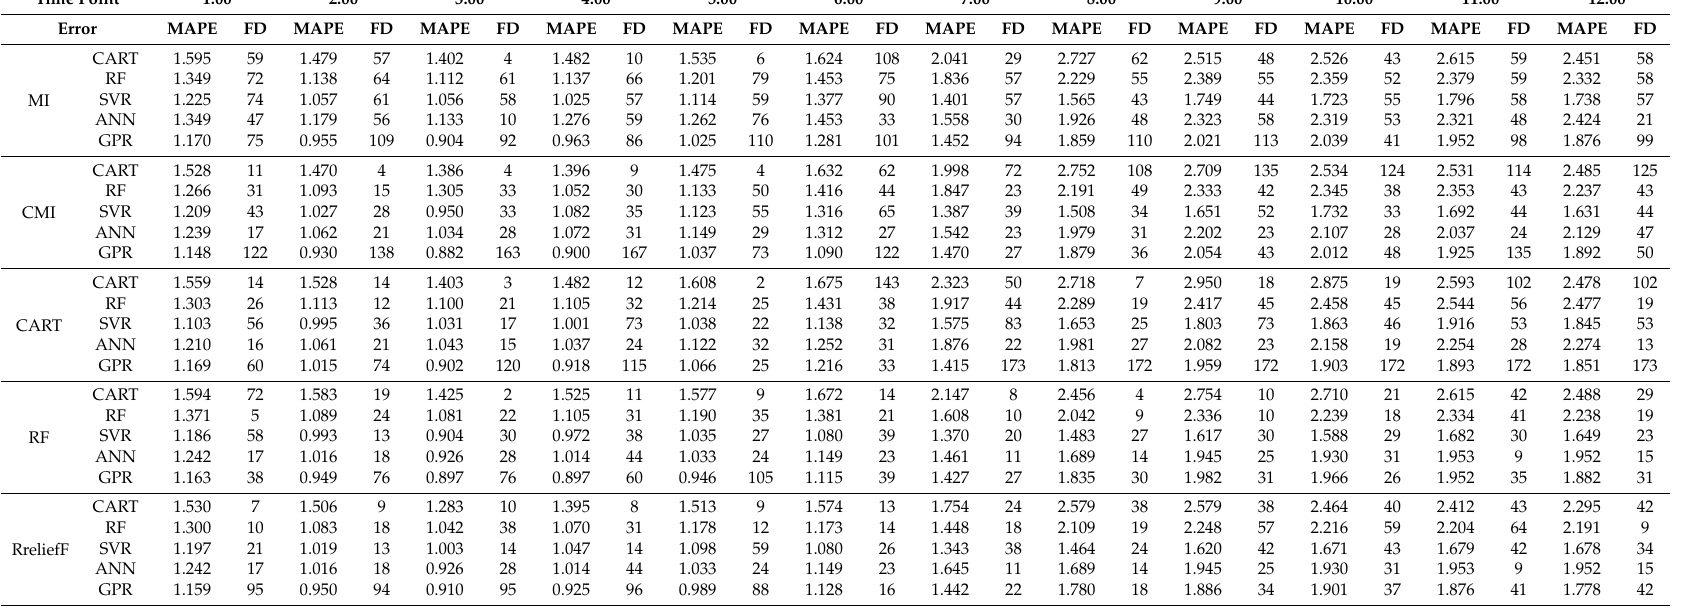
Table A3. Optimal feature subset construction of different hours from 1:00 to 12:00 with different methods for